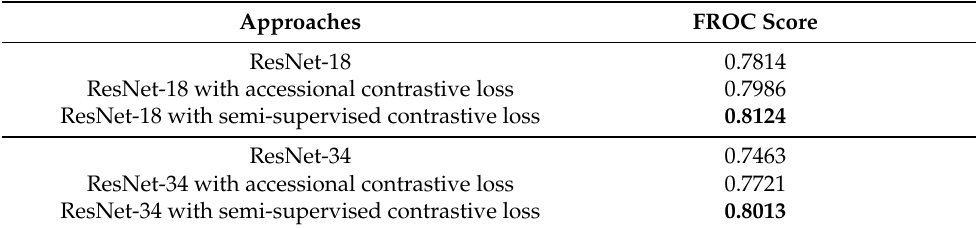
Table 3. Performance evaluation of semi-supervised contrastive loss.